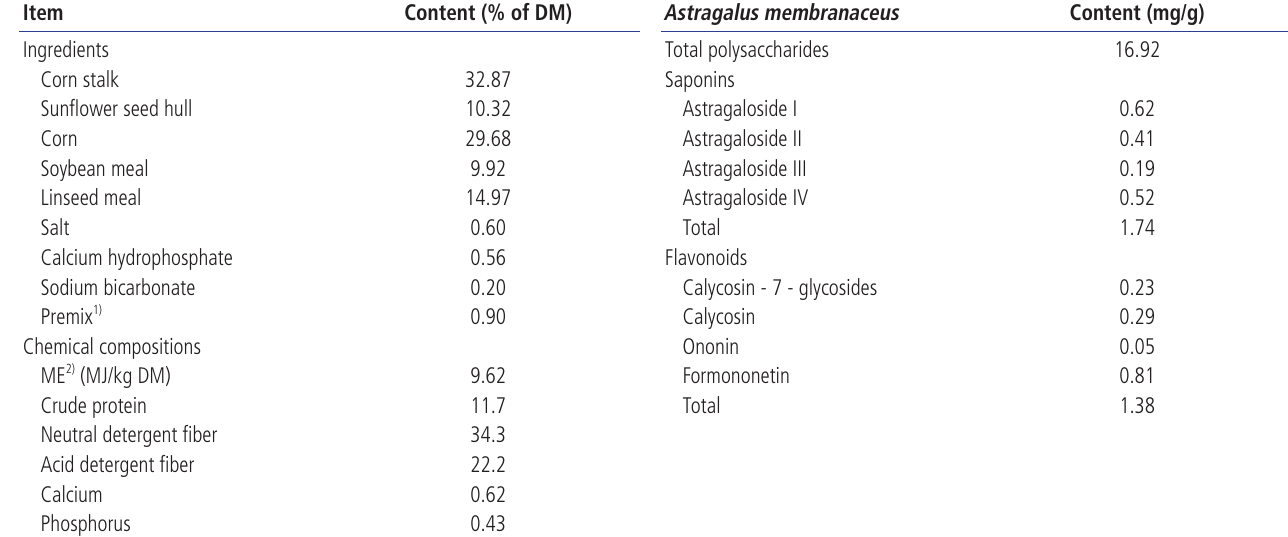
Table 1. Ingredients and chemical compositions of experimental diets and active ingredients of Astragalus